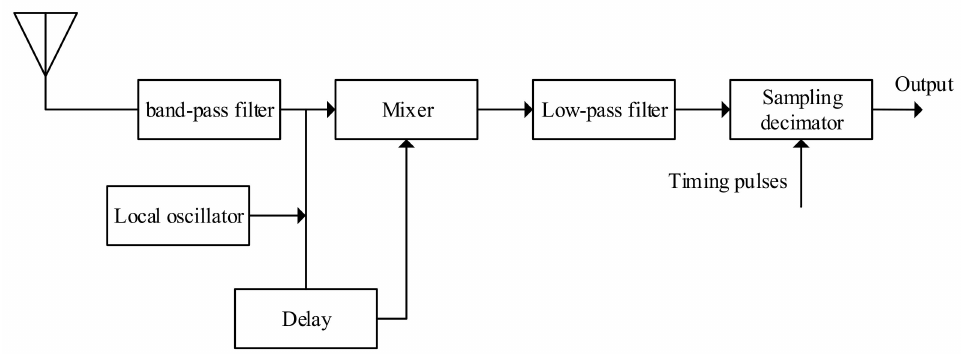
Figure 1. Typical communication receiver block